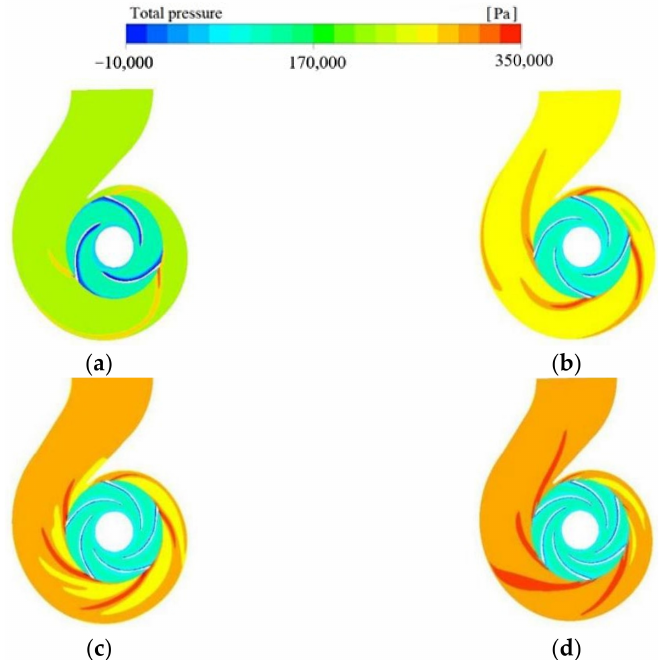
Figure 15. The total pressure in pump cross-section at different numbers of blades: ( a ) three-blade; ( b ) four-blade; ( c ) five-blade; ( d )